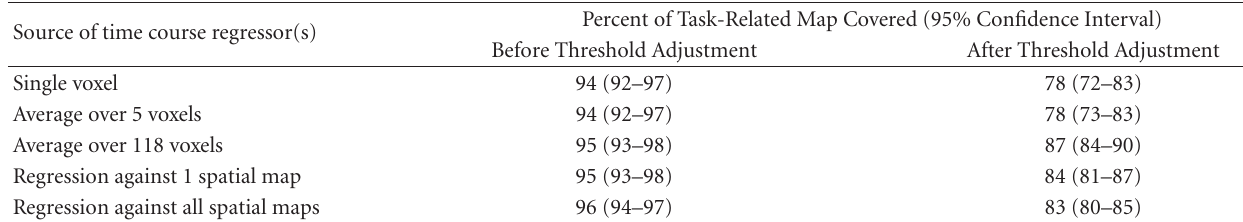
Table 2: Experiment 2: mean percentages of thresholded task-related GLM maps that are covered by thresholded FC maps generated with each hybrid ICA-seed-based method. The right-most column gives percentages after adjusting the z-score used to threshold the FC maps up or down so that number of false positives equals number of false